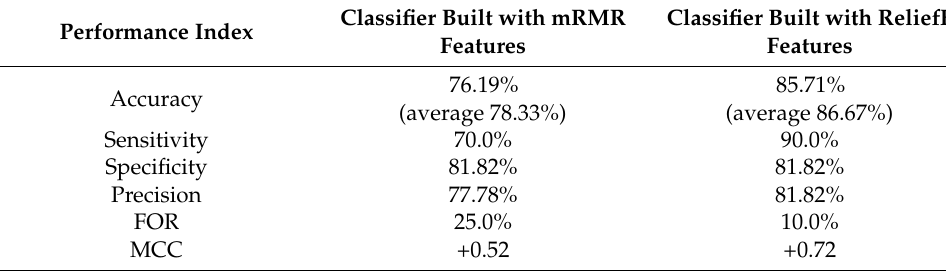
Table 5. Performances of classifiers built with features selected through both